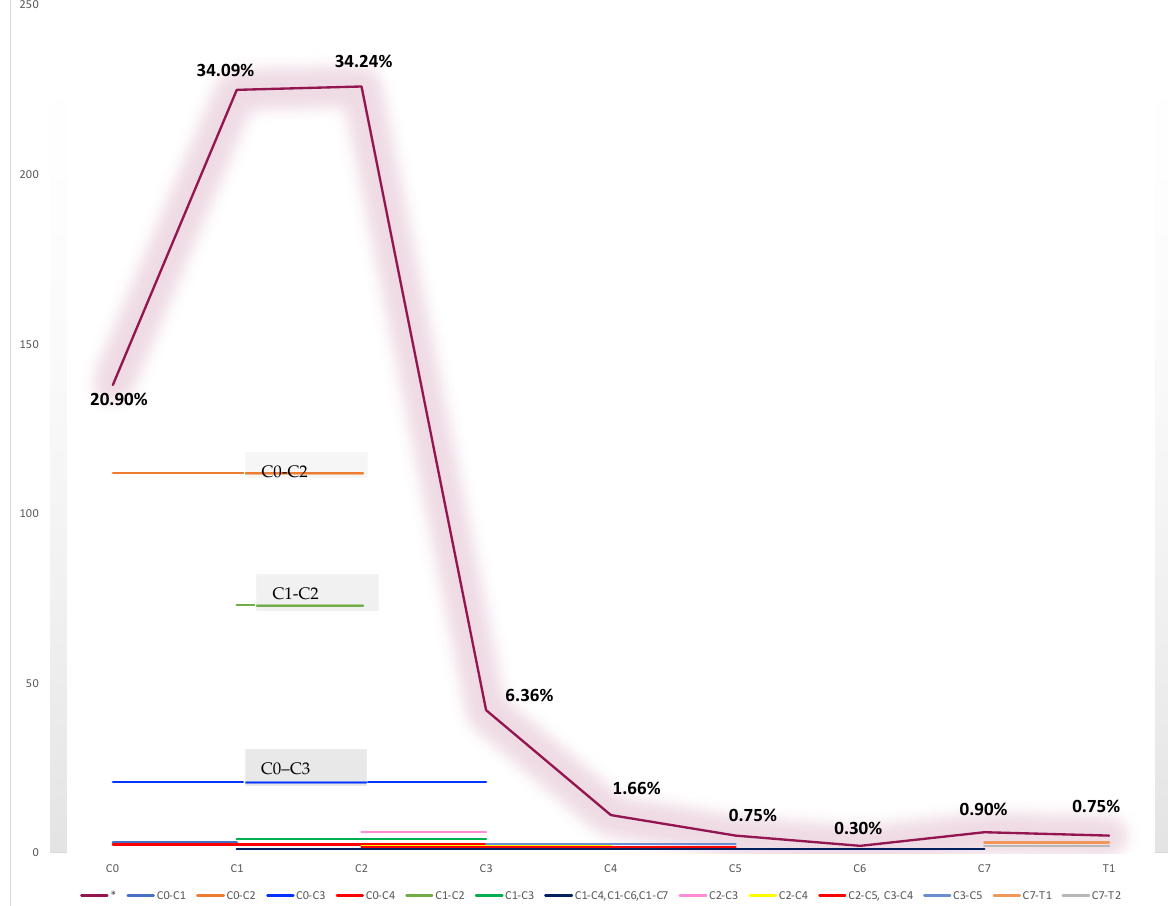
Figure 3. The purple line (*) shows the rate of patients that were affected by spinal cord compression related to the cervical levels, with a clear prevalence of the cranio-vertebral junction (C0–C2). In Figure 3, we show the main cervical spine level that is involved with a clear prevalence of the cranio-vertebral junction (C0–C2), including a total of 197 patients (79.73%). The different etiologies of MPS cervical compression were investigated and 15.38% (n = 38) of the cases were related to flavum ligamentum hypertrophy and dura mater thickening, 14.57% (n = 36) cases were due to atlanto-axial instability, and 65.58% (n = 162) of cases were due to the association of both conditions. Moreover, 39.67% of patients that were included in this review that were affected by MPS Type IV cervical myelopathy were related to atlanto-axial instability, while in 23.88% of patients with MPS Type VI were due to cervical stenosis. Patients that were included in this review presented clinical symptoms of motor disturbances, ranging from 78.07% of myelopathy symptoms, to 70.17% of paresis, 1.31% of plegia, and 47.80% alteration or/and inability to walk. Surgical treatment of choice was osteo-ligamentous decompression in 92.30% of patients (n = 228), and was associated to fusion in 45.17% of cases (n = 103). The median follow-up was about 61.31 ± 65.07 months, with a comprehensive evaluation of patients’ postoperative neurological status. The clinical outcome improved in 90.04% (n = 199), deteriorated in 4.07% (n = 9), while was stable in 5.42% of cases (n = 12). Furthermore, according to our literature review, among 10 studies (27.02%) surgery was delayed, with a mean time of 2.9 years after diagnosis of cervical myelopathy. In the other 27 studies (72.97%), surgery was planned immediately after the diagnosis of cervical